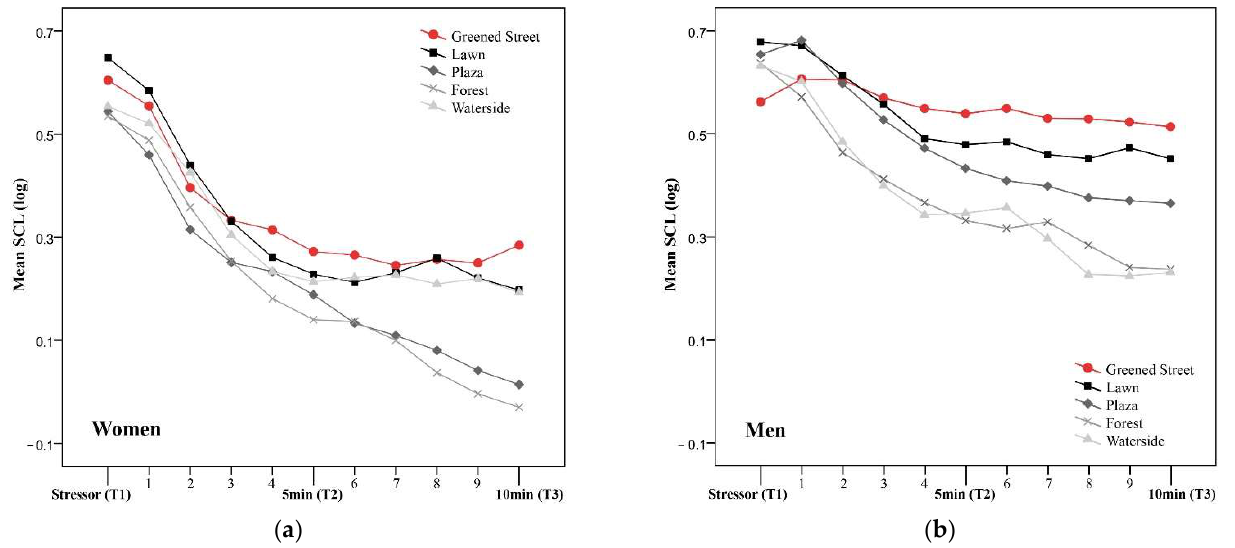
Figure 3. Minute-by-minute skin conductance level (SCL) changes of women ( a ) and men ( b ) in different environments during the recovery phase.